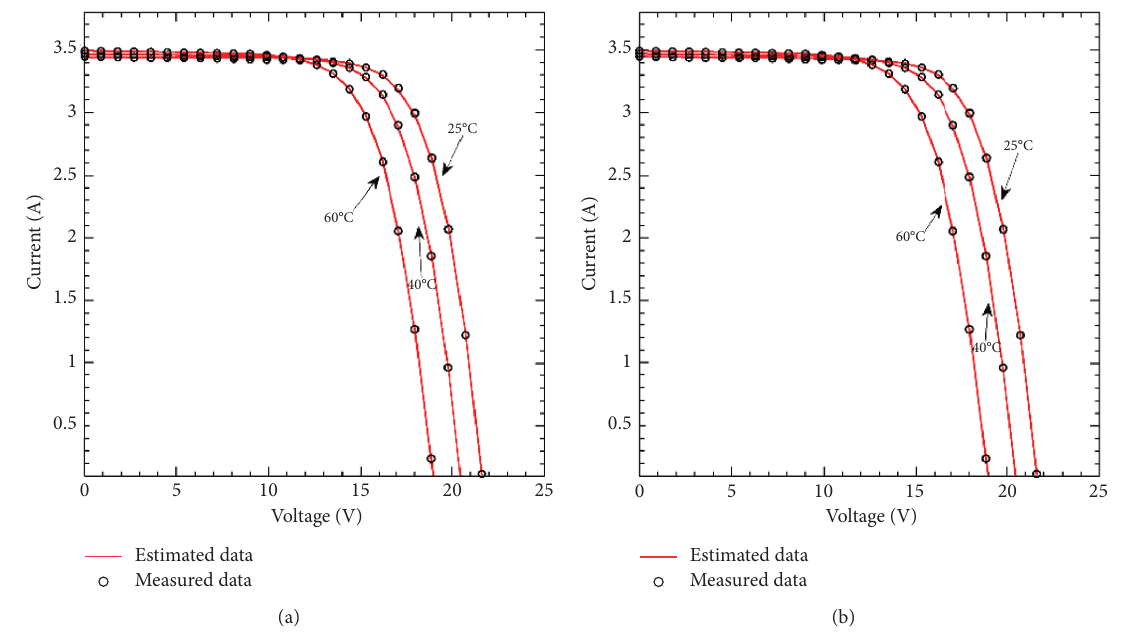
Figure 15: I-VC of (a) SDM and (b) DDM for monocrystalline SM55 at different